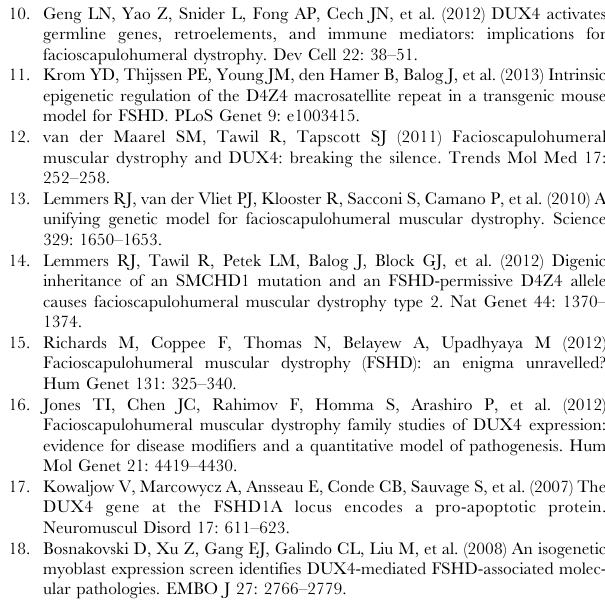
to Table 1. Tables S2 and S3 additionally include peak enrichment estimates calculated by comparing observed propor- tions of peaks overlapping each repeat type to the repeat content of randomly sampled AT-content-matched 17-mers (see Methods). Table S3 Enrichment estimates for each repeat family among ChIP-seq peaks, ChIP-seq reads and RNA-seq reads. Repeat families are shown sorted by peak-based enrichment estimate. Table S4 DUX4-bound regions used as previously undescribed alternative promoters for annotated genes (see Methods). We note that HEY1 does not appear in this list for technical reasons, because several intervening exons are spliced between the DUX4- bound repeat and the annotated gene, so that no 100 bp sequencing read directly joins the repeat and HEY1 . Table S5 DUX4-bound regions used as previously undescribed alternative promoters for annotated lncRNAs (see Methods). Table S6 Primers used for RT-PCR and 5 9 -RACE